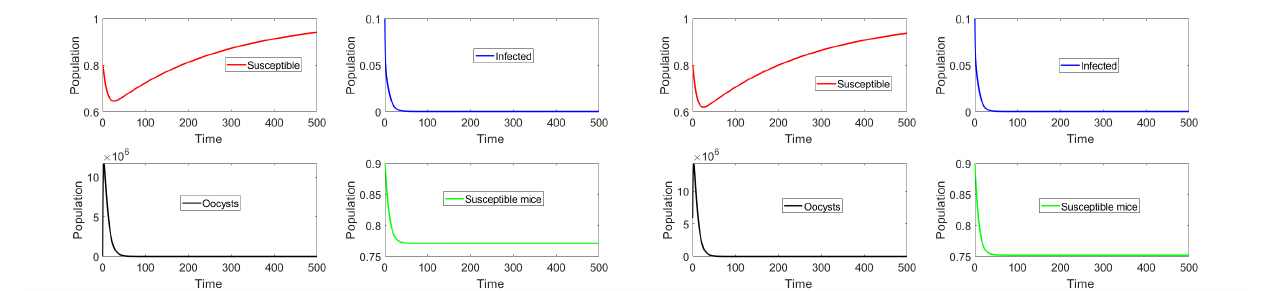
Figure 2. Trajectories of the subpopulations with no vaccination and R 0 = 0.98. The initial subpopu- lations are near the toxoplasmosis-free point F ∗ . On the right-hand side, the initial amount of oocysts O ( 0 ) is very large.